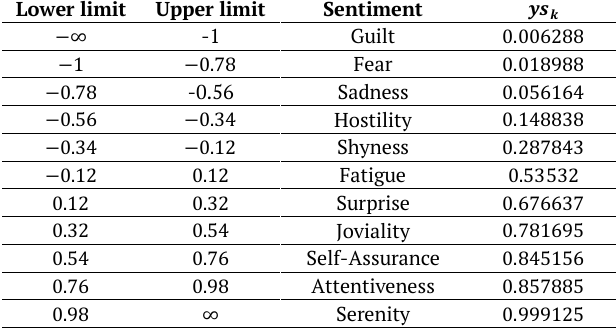
Table 2. Stochastic cumulative distribution Softmax function Lower limit Upper limit